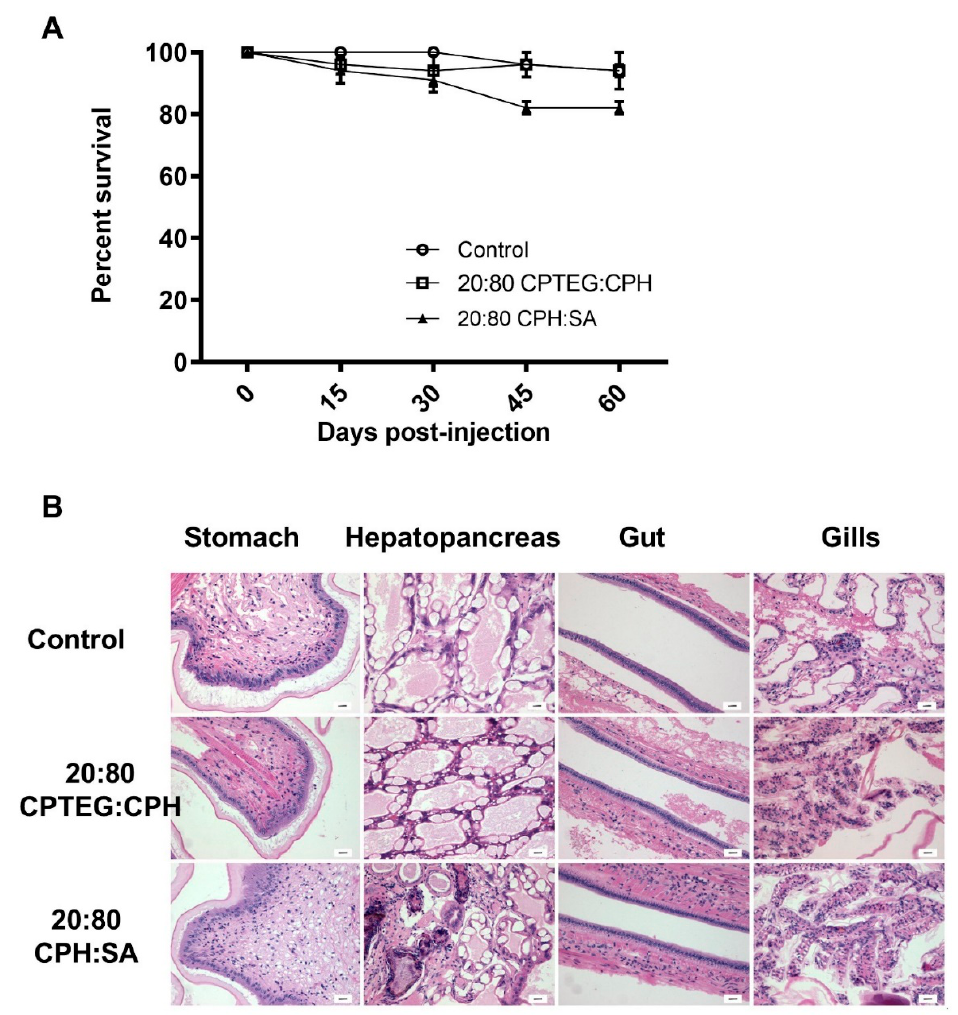
Figure 3. Safety profile of nanoparticles in shrimp. Shrimp were injected with 500 mg of either 20:80